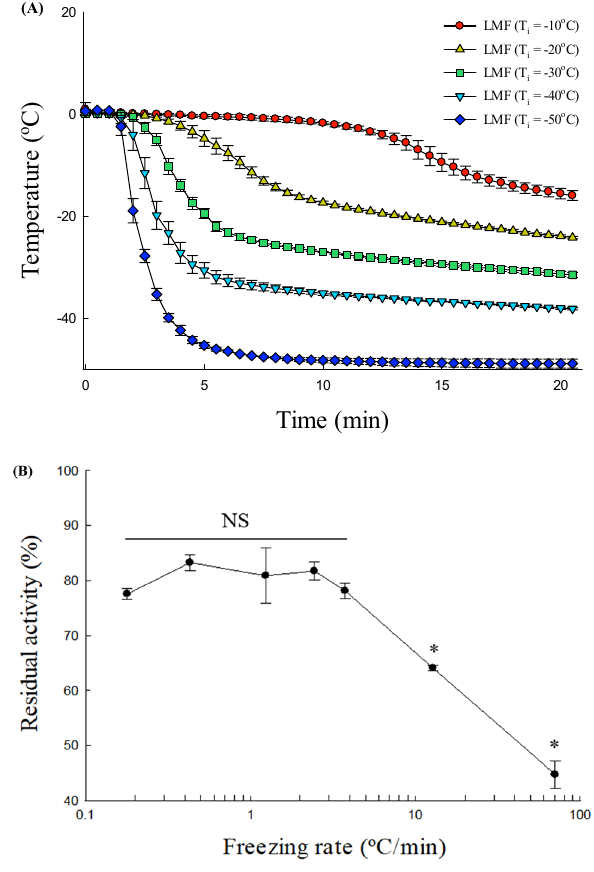
Figure 2. ( A ) Freezing curves of the l-lactate dehydrogenase (LDH) solution (20 μg/mL, 0.2 M Tris–HCl buffer, pH 7.4) at different liquid-mediated freezing (LMF) conditions [T i ] = − 10, − 20, − 30, − 40, or − 50 °C). T i , the temperature of isopropyl alcohol just before freezing LDH samples. ( B ) Effect of freezing rate on the activity of LDH dissolved in 0.2 M Tris–HCl buffer (pH 7.4). Results are expressed as the means ± SDs. Asterisks (*) indicate significant differences ( p < 0.05). NS non-significant difference.